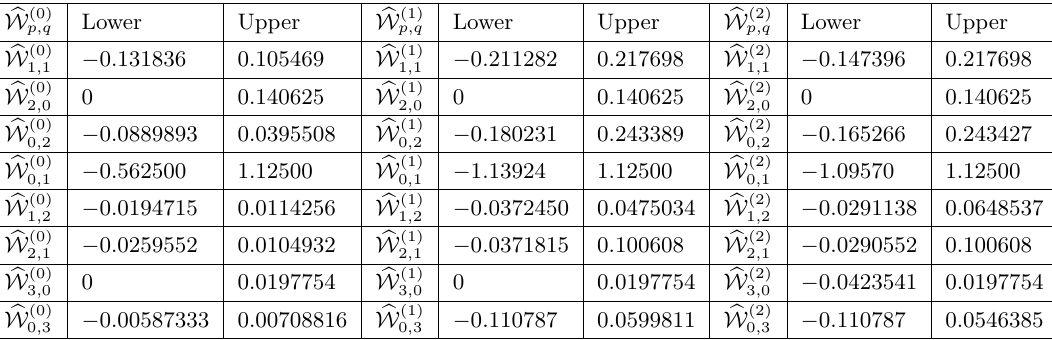
Table 2 . Bounds on c W ( k ) p,q for n = 3